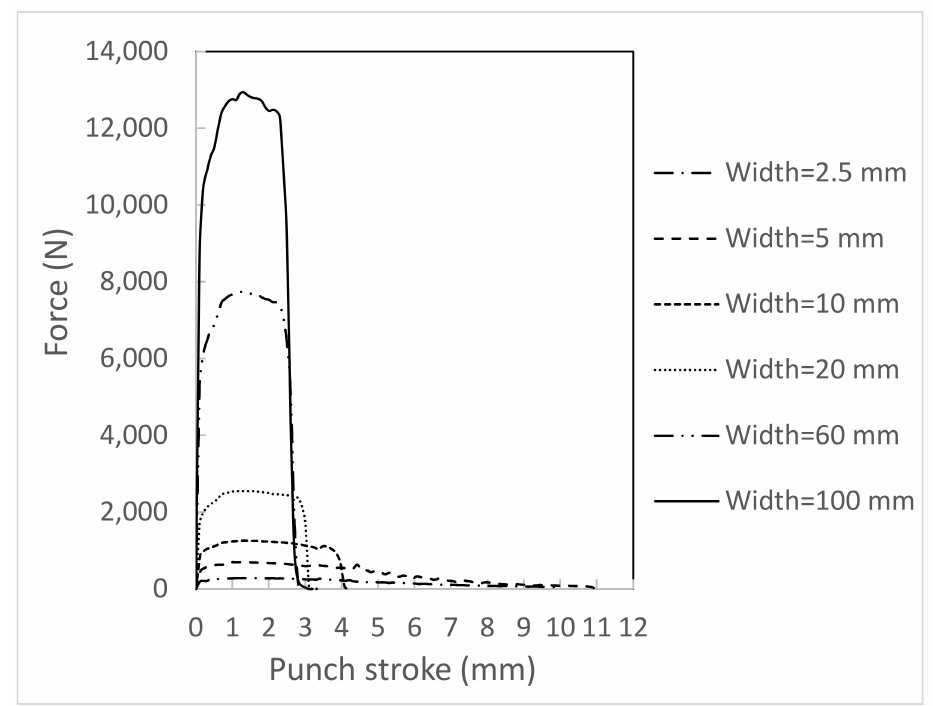
Figure 6. Force-displacement curves in metal sheets with various